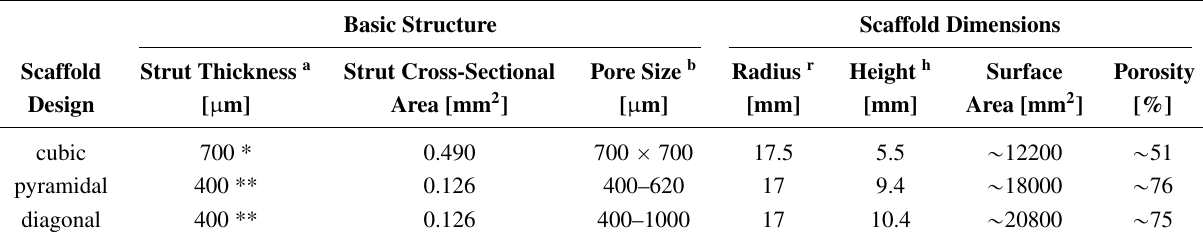
Table 1. Geometrical parameters of the generated Ti-6Al-4V scaffolds.